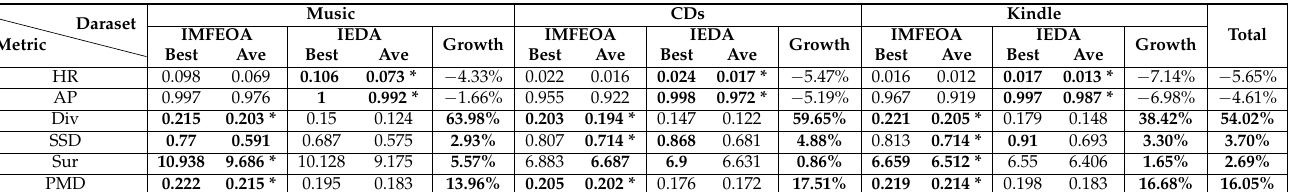
Table 5. Combined evaluation results of six metrics for both